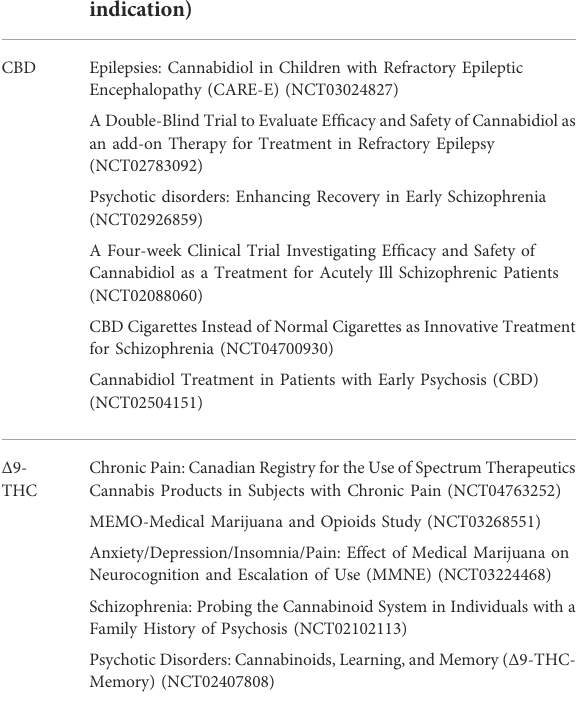
TABLE 4 Ongoing clinical trials using CBD or Δ 9-THC, according to a database search (active, not recruiting) at clinical trials.gov. Search Trials (grouped by